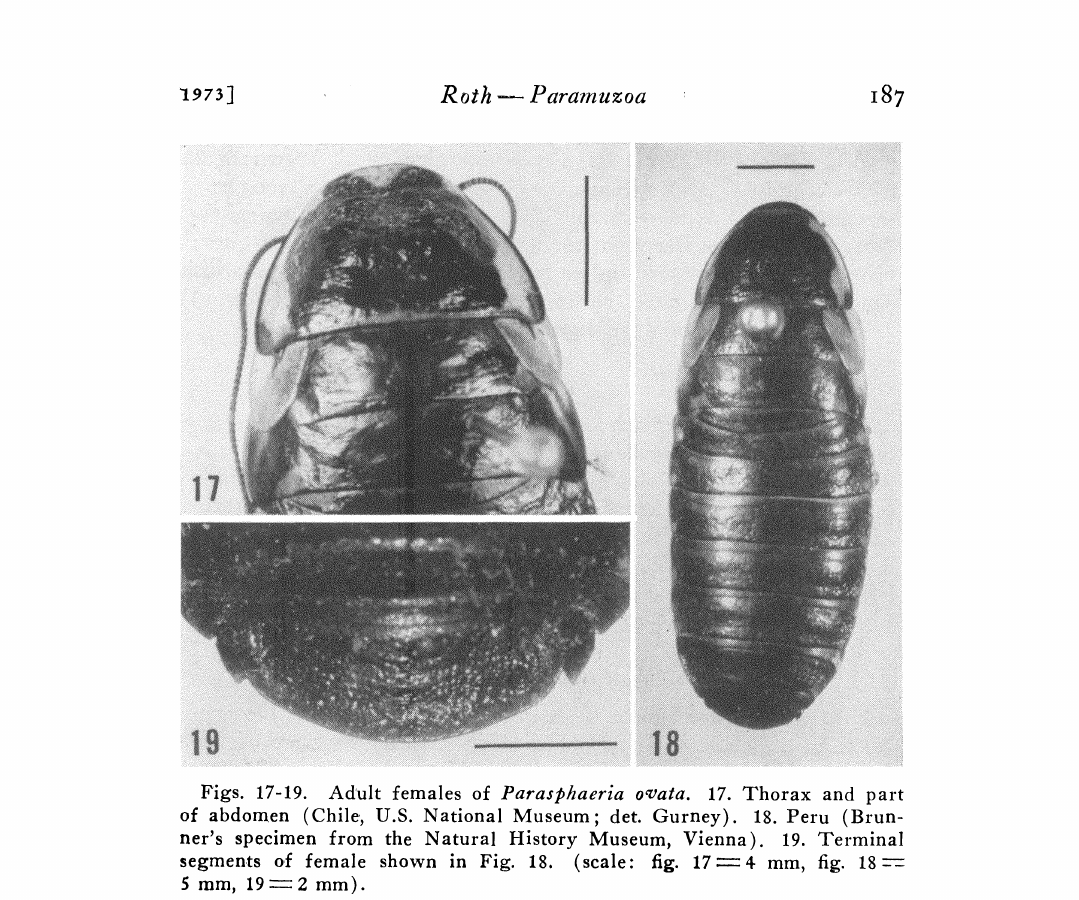
Figs. 17-19. Adult females of Parasphaeria oata. 17. Thorax and part of abdomen (Chile,, U.S. National Museum; det. Gurney). 18. Peru (Brun- her’s specimen from the Natural History Museum, Vienna). 19. Terminal segments o.f female shown in Fig. 18. (scale: fig. 17----4 mm, fig. 18--=- 5 mm, 192